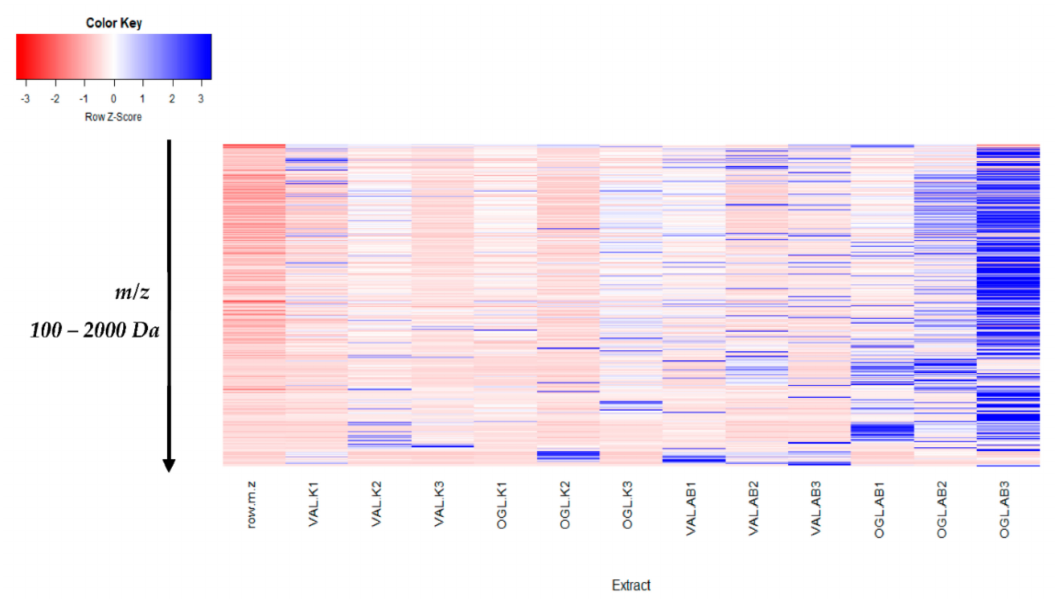
Figure 5. Heatmap visualising the intensities of secondary metabolites. AB-Abraka; KK—Kokori; VAL— Vernonia amygdalina leaves; OGL— Ocimum gratissimum